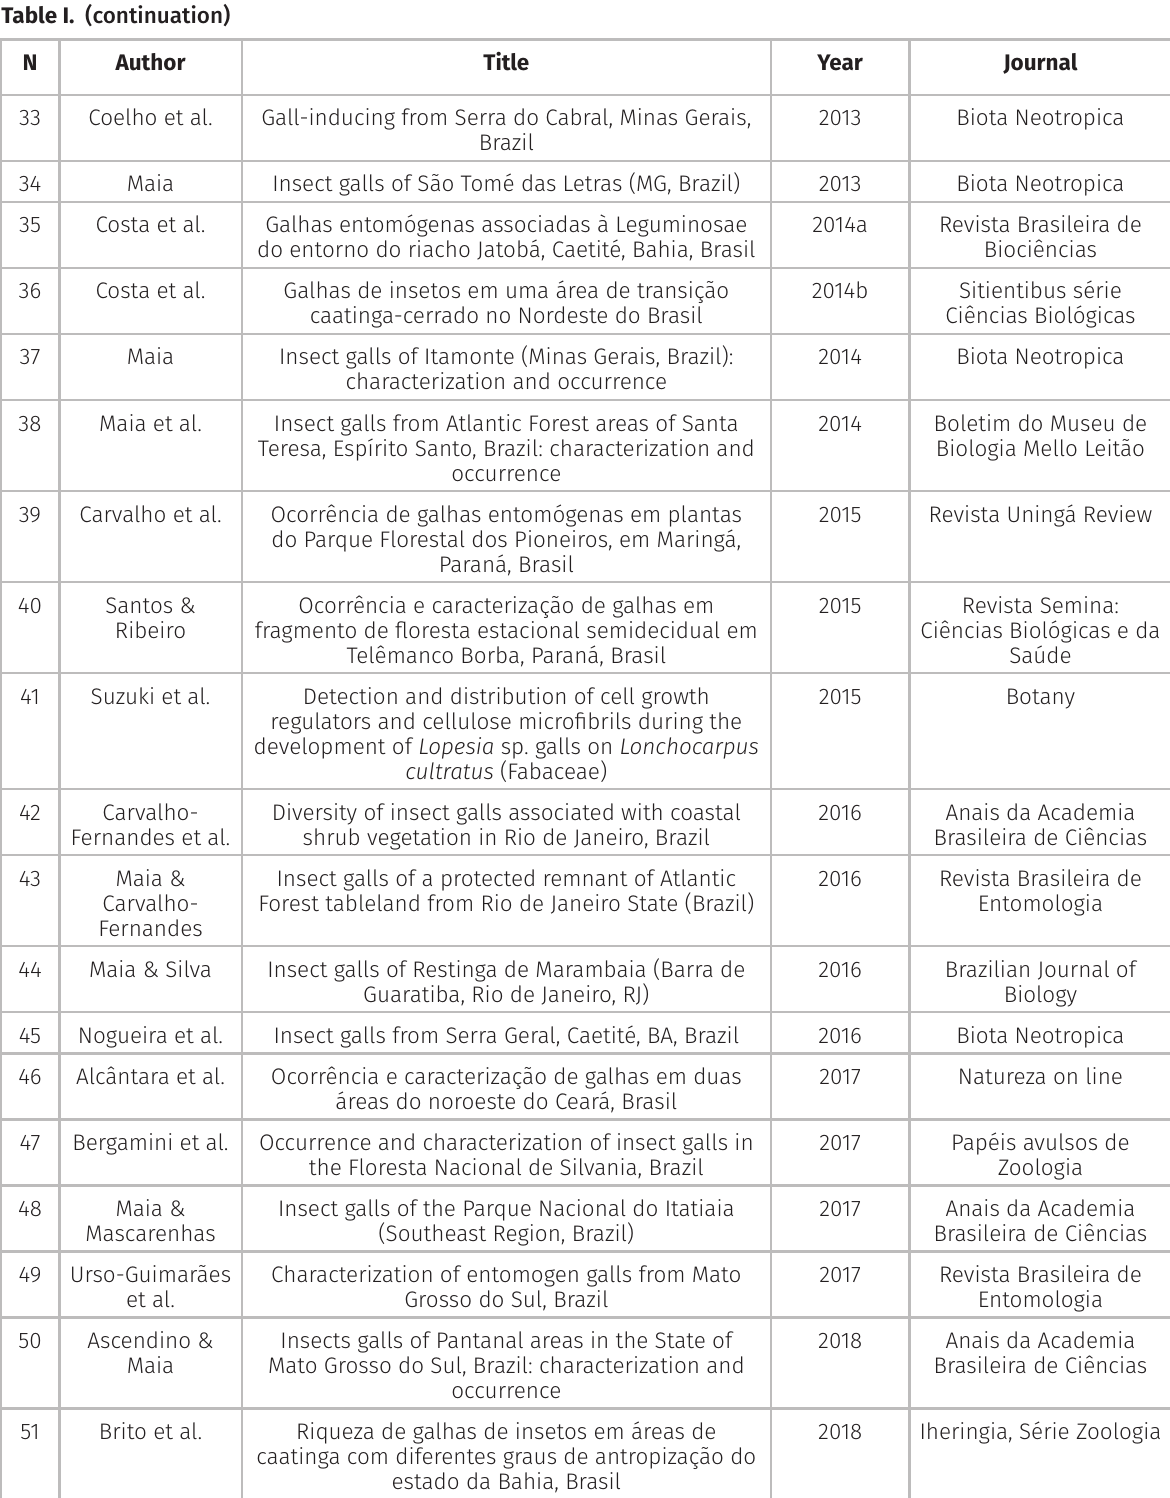
Table I. (continuation)